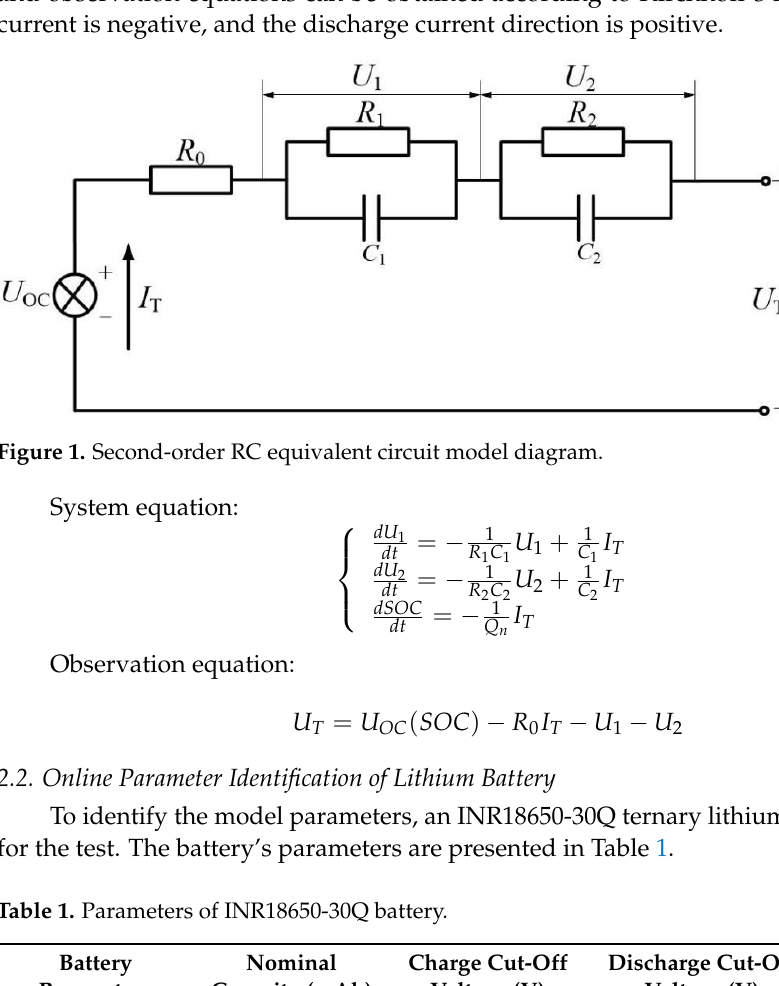
Table 1. Parameters of INR18650-30Q battery.